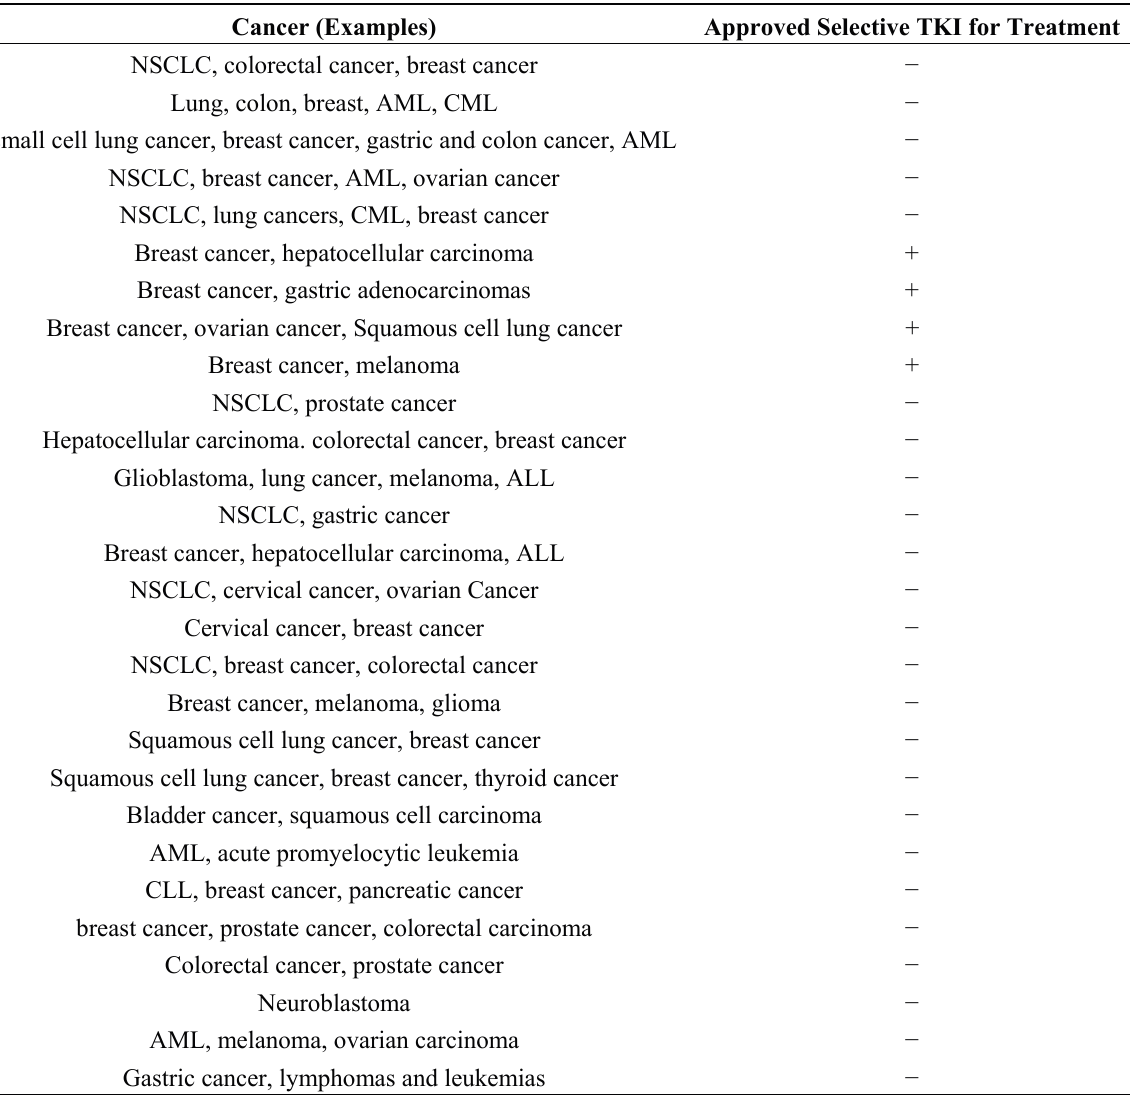
Table 1. Oncogenic receptor tyrosine kinases in